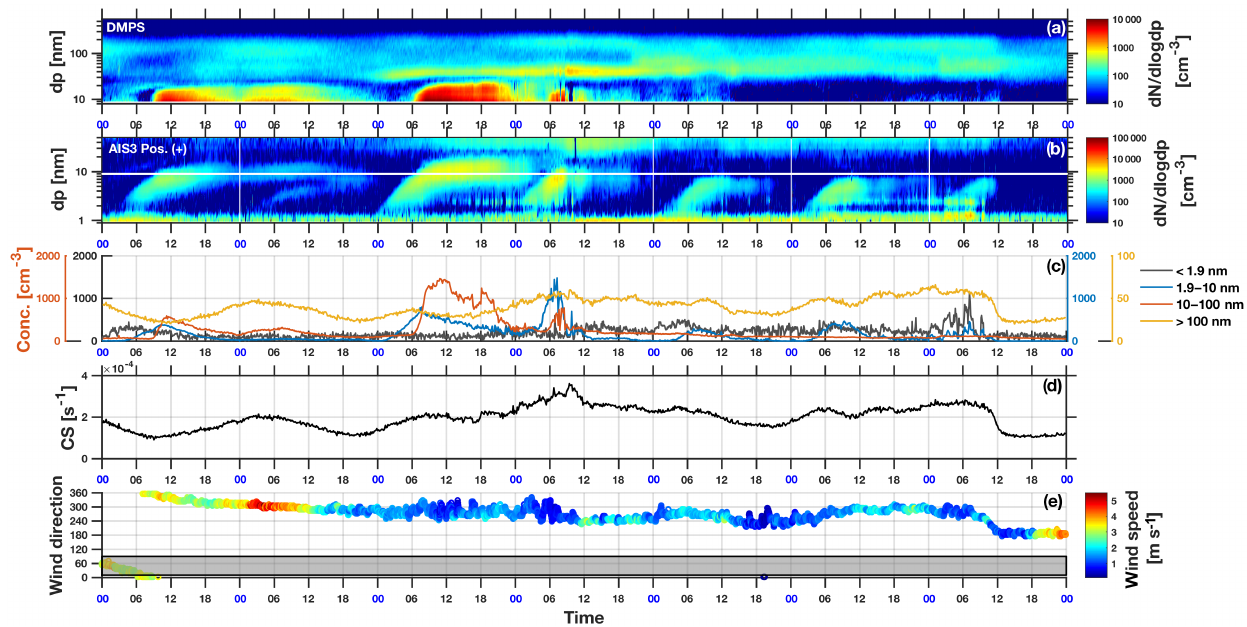
Figure 3. Consecutive NPF events observed during the period 9–15 March 2011. (a) DMPS spectra; (b) AIS positive polarity spectra; (c) ion and particle concentrations in four different size ranges: 0.9–1.9nm (ions), 1.9–10nm (ions), 10–100nm (total particles), and total particles of diameters above 100nm; (d) CS; and (e) wind direction, colour-coded for wind speed. The white line in (b) indicates the lower limit of the DMPS size range. The grey band in (e) represents the contaminated wind sector. Data are presented in